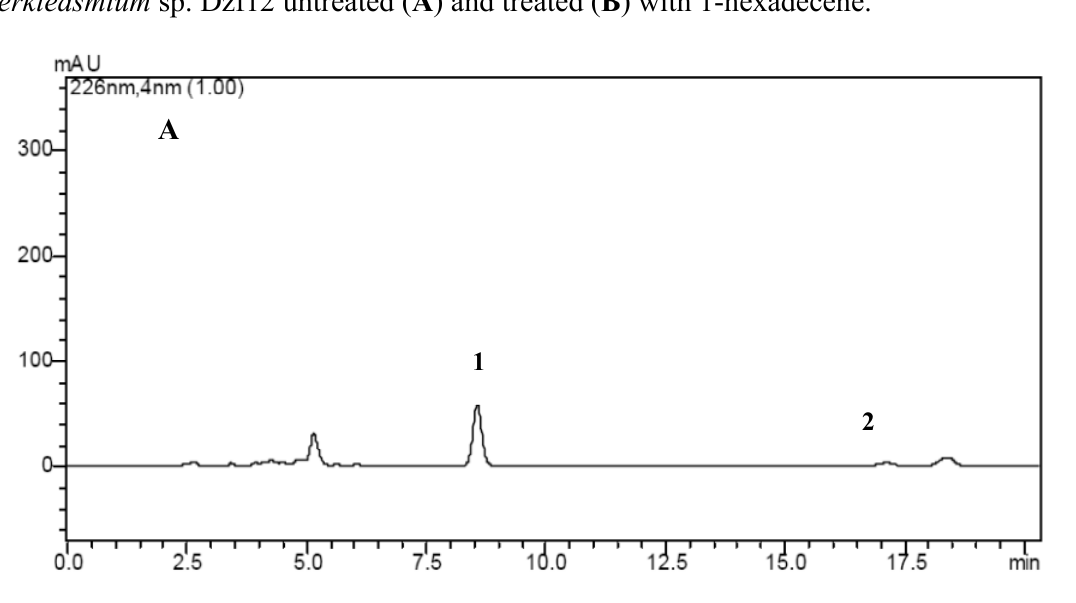
Figure 1. HPLC chromatograms of the crude ethyl acetate extracts from endophytic fungus Berkleasmium sp. Dzf12 untreated ( A ) and treated ( B ) with